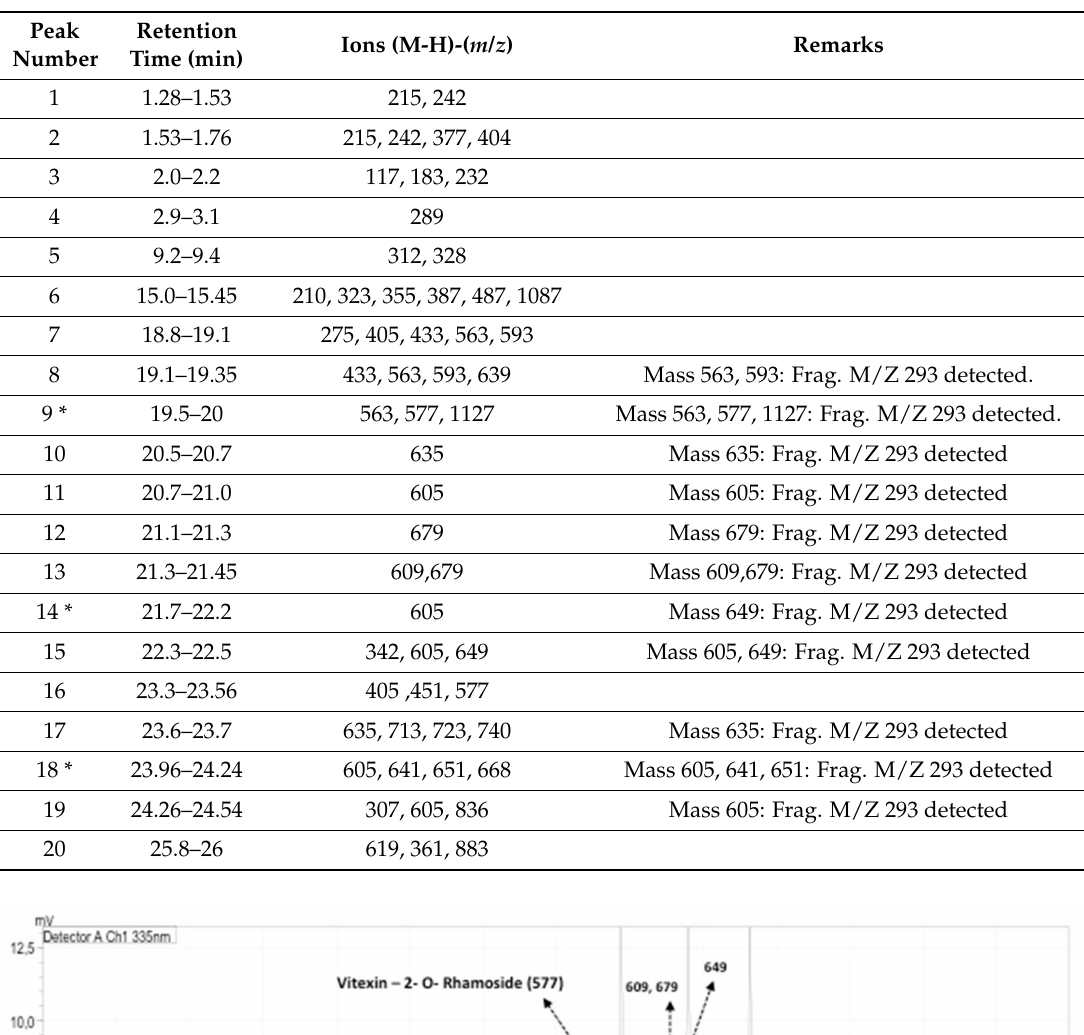
Table 4. Ions detected ( m / z ) in the extracts. * indicates a major peak in the chromatogram. The numbers in bold indicate compounds showing the ion ( m / z ) 293.